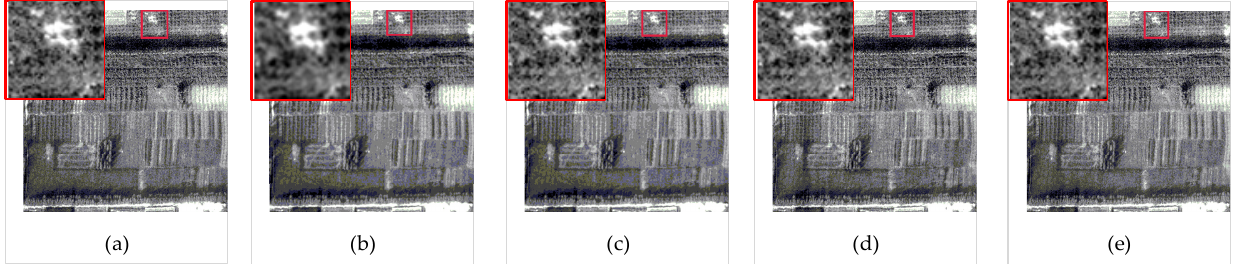
Figure 7. The denoising results of band 15 in Xiong’an. ( a ) Original image; ( b ) denoised result of KMNF-NE; ( c ) denoised